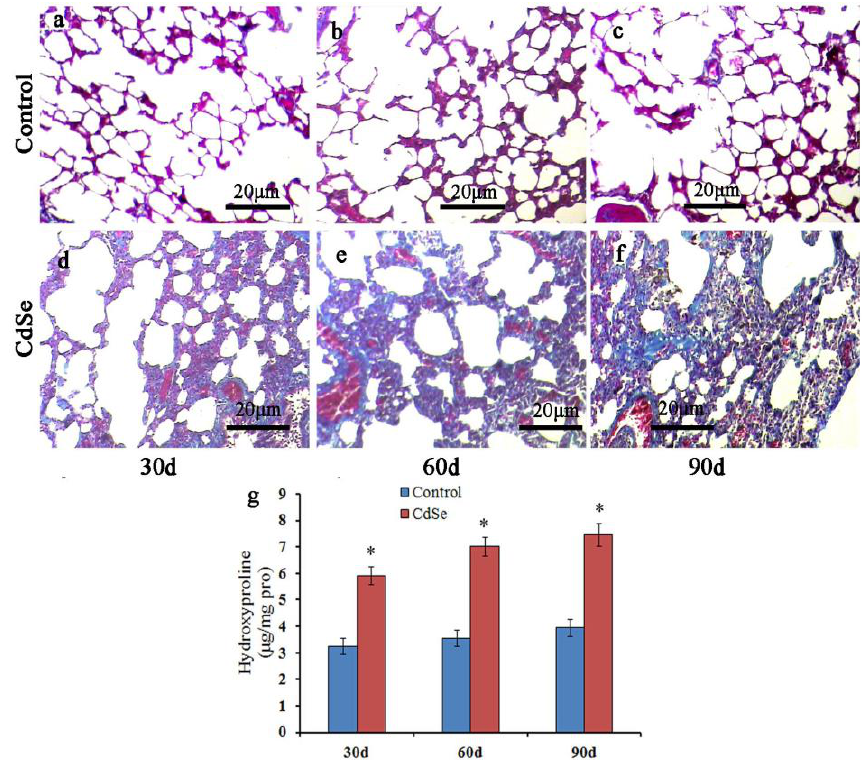
Figure 2. Masson trichrome staining to assess the pulmonary fibrosis. Compared with control groups ( a – c ), the collagen deposition increased significantly in lung interstitium at 30 ( d ), 60 ( e ), and 90 ( f ) days in CdSe nanorod-induced lung tissues. Detection of hydroxyproline content in lung tissues ( g ), similar to the changes in the collagen level, hydroxyproline level was also enhanced in CdSe nanorods-induced lungs on days 30, 60, and 90. Data are shown as mean ± SD (* p < 0.05, as compared with those in the normal control groups). The above typical pictures are selected from the lung tissues of 8 rats in each group.